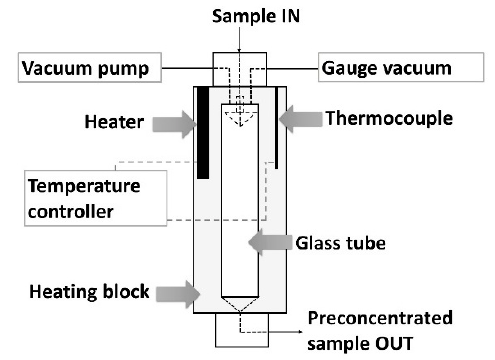
Figure 1. Scheme of the developed evaporation module